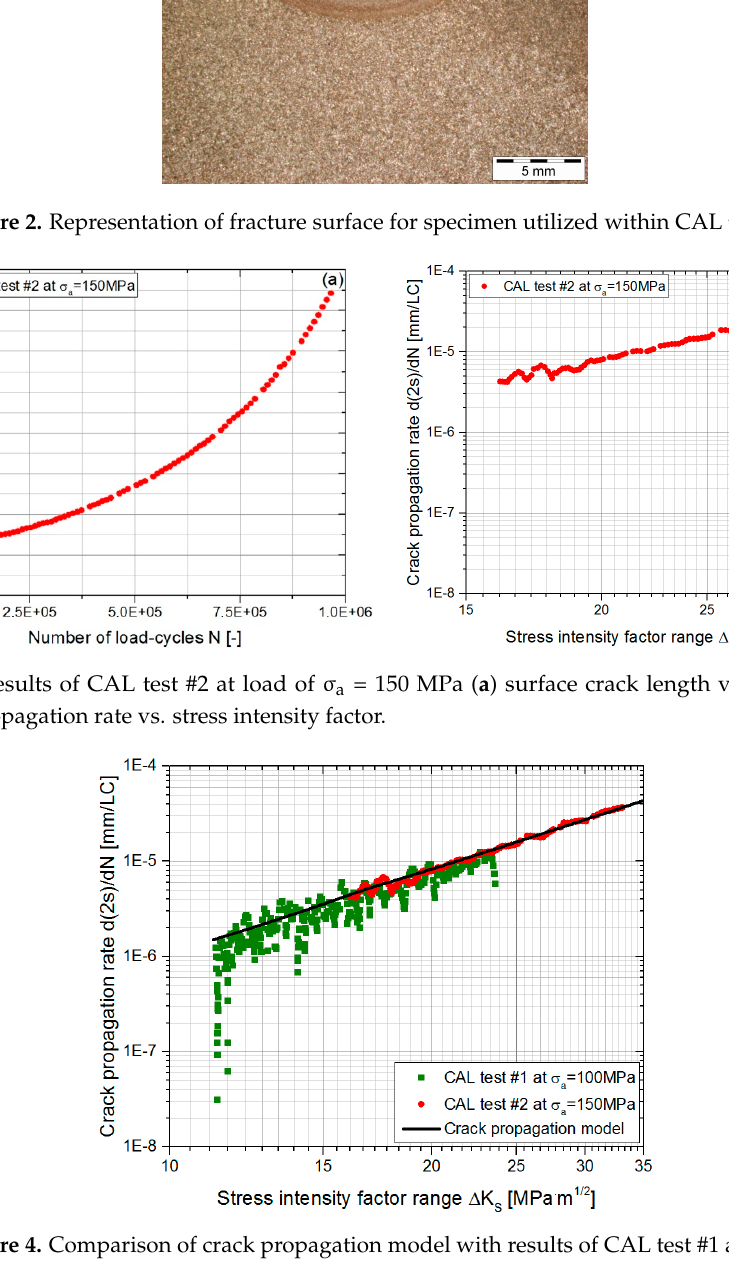
Figure 4. Comparison of crack propagation model with results of CAL test #1 and #2.